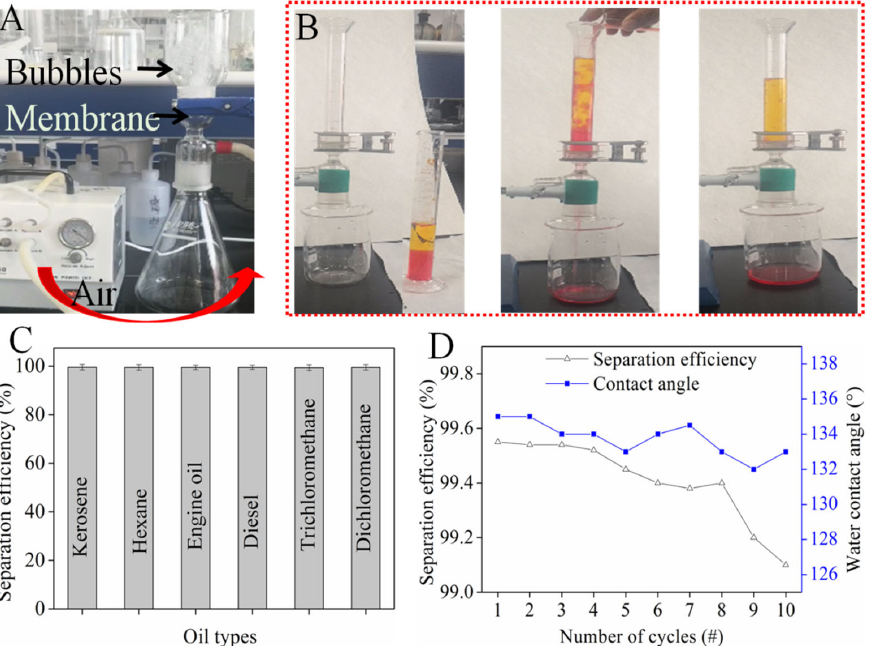
Figure 6. ( A ) Air permeability of membrane; ( B ) oil/water separation process; ( C ) separation efficiency of various oil–water mixture; ( D ) separation efficiency and contact angle of repeated tests.